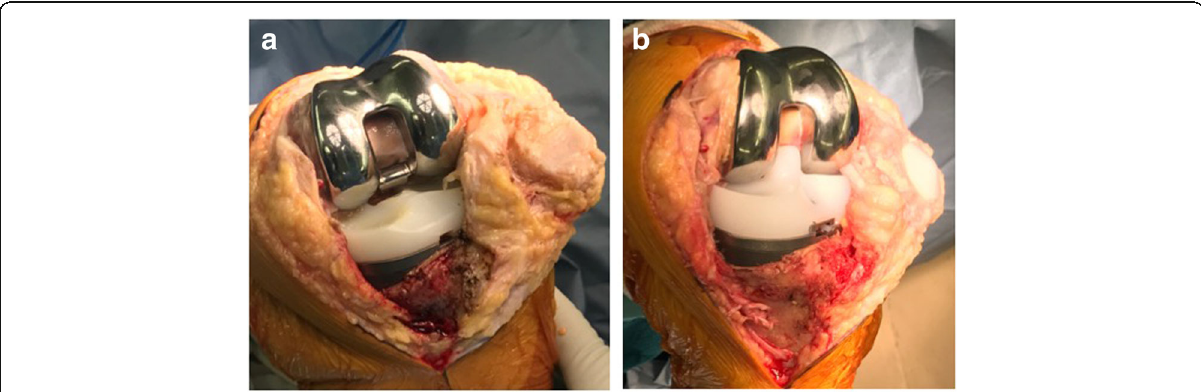
Fig. 5 Intraoperative macrographs. a the post of polyethylene insert was broken, and the patellar chondral surface was irregular and erosive. b the broken insert was replaced by thicker one to restore the varus-valgus instability the patella was